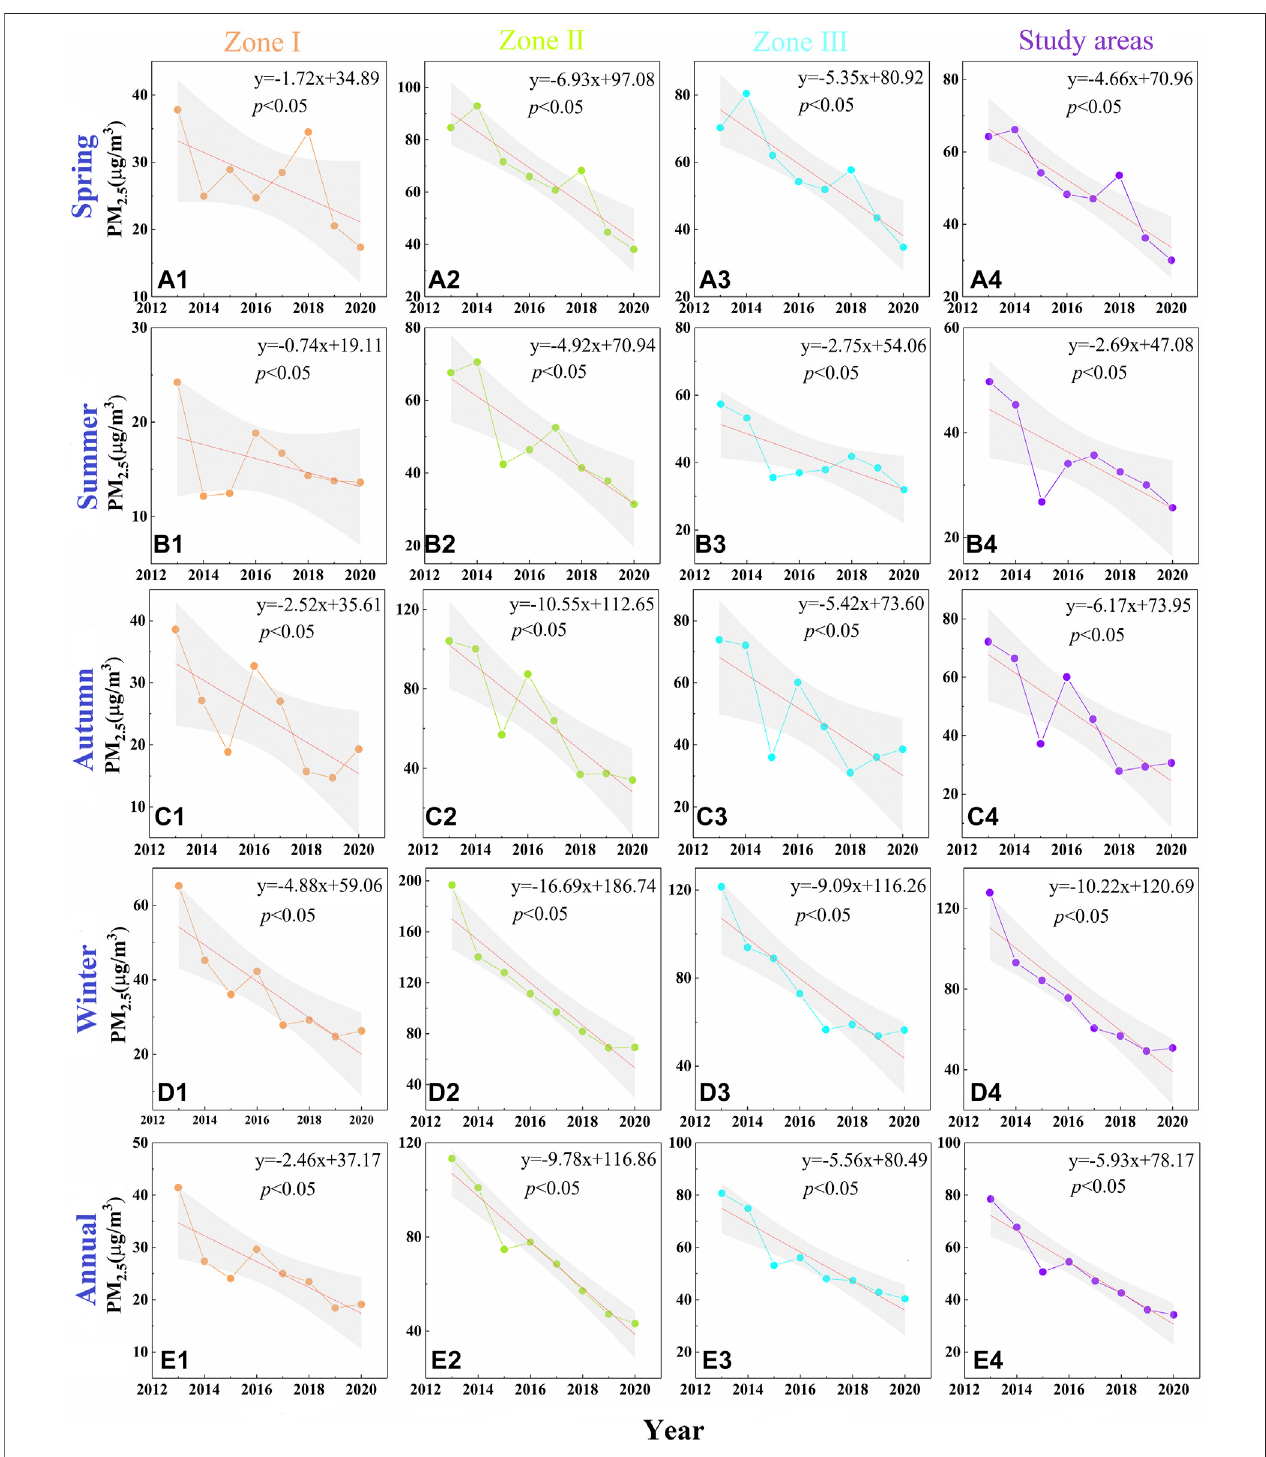
FIGURE 8 | Scatter plots of seasonal and annual trends of PM 2.5 concentrations in the Zone I (A1 – E1) , Zone II (A2 – E2) , Zone III (A3 – E3) , and the Beijing – Tianjin – Hebei region (A4 – E4) from 2013 to 2020. (The gray band represents the 95% con fi dence interval).